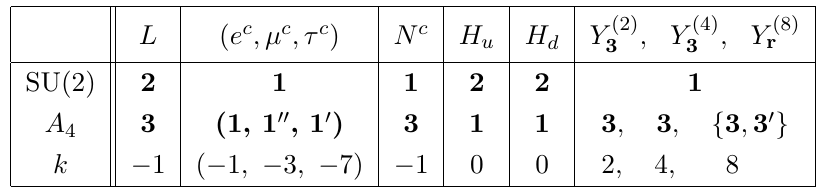
Table 6 . Representations and weights k for MSSM fields and modular forms of weights 2 , 4 and 8